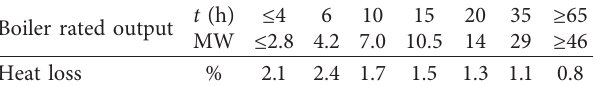
Table 4: Boiler heat loss table.